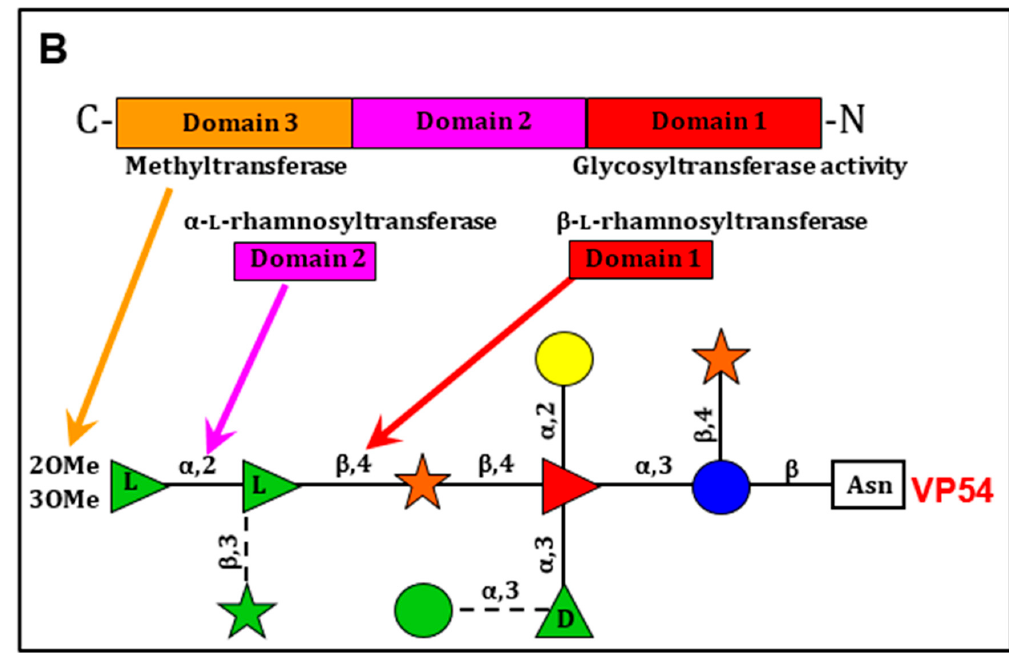
Figure 10. ( A ) PBCV-1 glycan structure with the predicted PBCV-1 encoded glycosyltransferases (named in the colored boxes) involved in the glycosidic bond formation. ( B ) Protein A064R has three domains with each domain carrying out a specific enzymatic function that has been verified biochemically: domain 1 is a β - L -rhamnosyltransferase that links L -rhamnose to D -xylose, domain 2 is an α - L -rhamnosyltransferase that links L -rhamnose to L -rhamnose, and domain 3 is a methyltransferase that places a methyl group at the 2 position on the terminal L -rhamnose [217]. The a075l gene is predicted to encode a β -xylosyltransferase that attaches the distal D -xylose unit